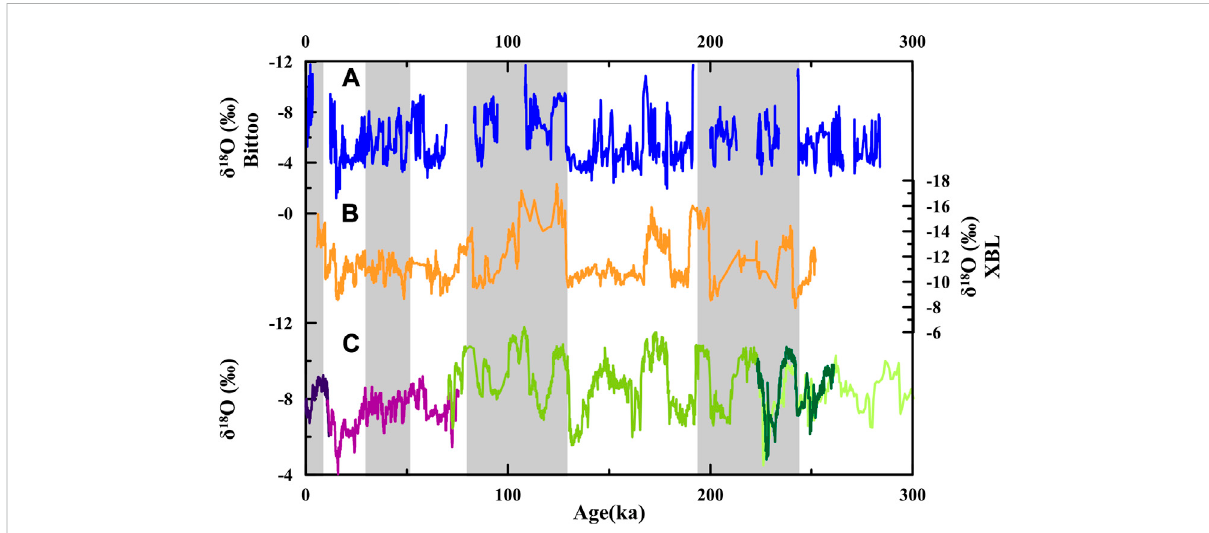
FIGURE 3 ComparisonbetweentheISMrecordsfromcavespeleothems. (A) δ 18 OfromBittooCaves(Kathayatetal.,2016); (B) δ 18 OfromXiaobailongCave (Cai et al., 2015); (C) δ 18 O from Hulu Cave (purple) (Wang et al., 2001), Dongge Caves (dark blue) (Yuan et al., 2004), Sanbao Cave [light green (Wang et al., 2008), dark green (Cheng et al., 2009)] and Linzhu Cave (yellow-green) (Cheng et al.,